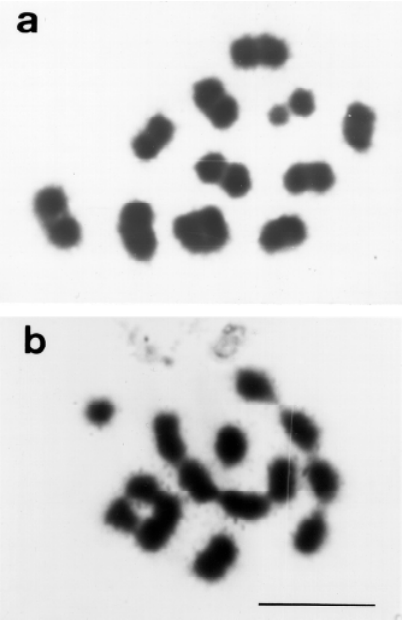
Figure 2 - Meiotic chromosomes from karyological group II specimens of Physalaemus petersi stained with Giemsa. In a , 11 isolated bivalents. In b , associated bivalents forming two open multivalent chains. Bar = 10 m